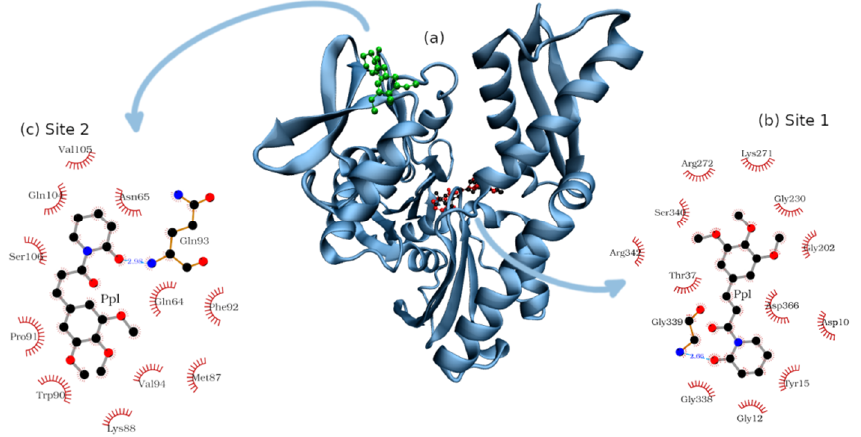
Figure 9. Bind sites of NBD accessed by PPL: ( a ) NBD structure with PPL in Site 1 (red) and in Site 2 (green), in this picture ADP molecule is represented in black. ( b ) The amino acids composition of Site 1 and the interactions between PPL and NBD, where one hydrogen bond was found between Gly339 and PPL (blue dashed line). ( c ) The amino acids composition of Site 2 and the interactions between PPL and NBD, where one hydrogen bond was found between Gln93 and PPL (blue dashed line).